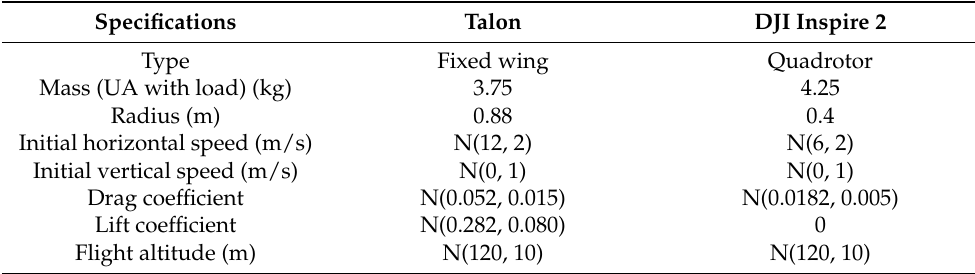
Table 5. Specifications of